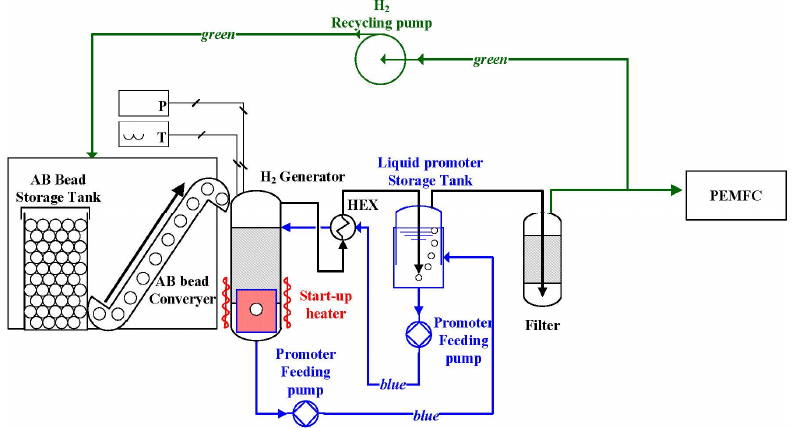
Figure 9. Schematic of the advanced fuel cell system powered by ammonia borane for prolonged operation. Reprinted with permission from reference [116]. Copyright 2014